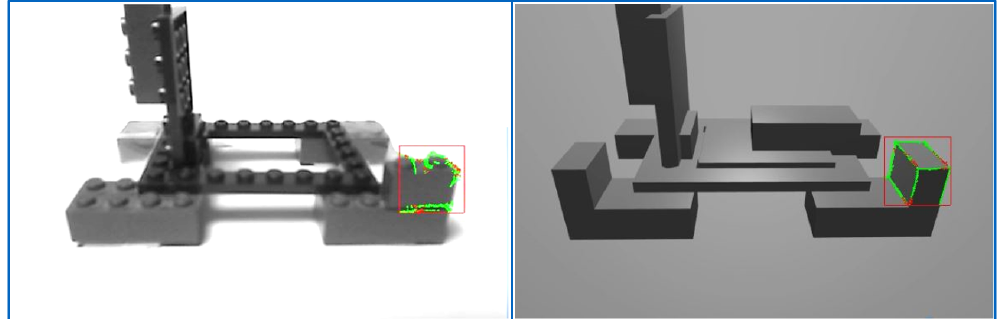
Figure 13. Unsuccessful validation phase: comparison between real object (on the left) and virtual model (on the